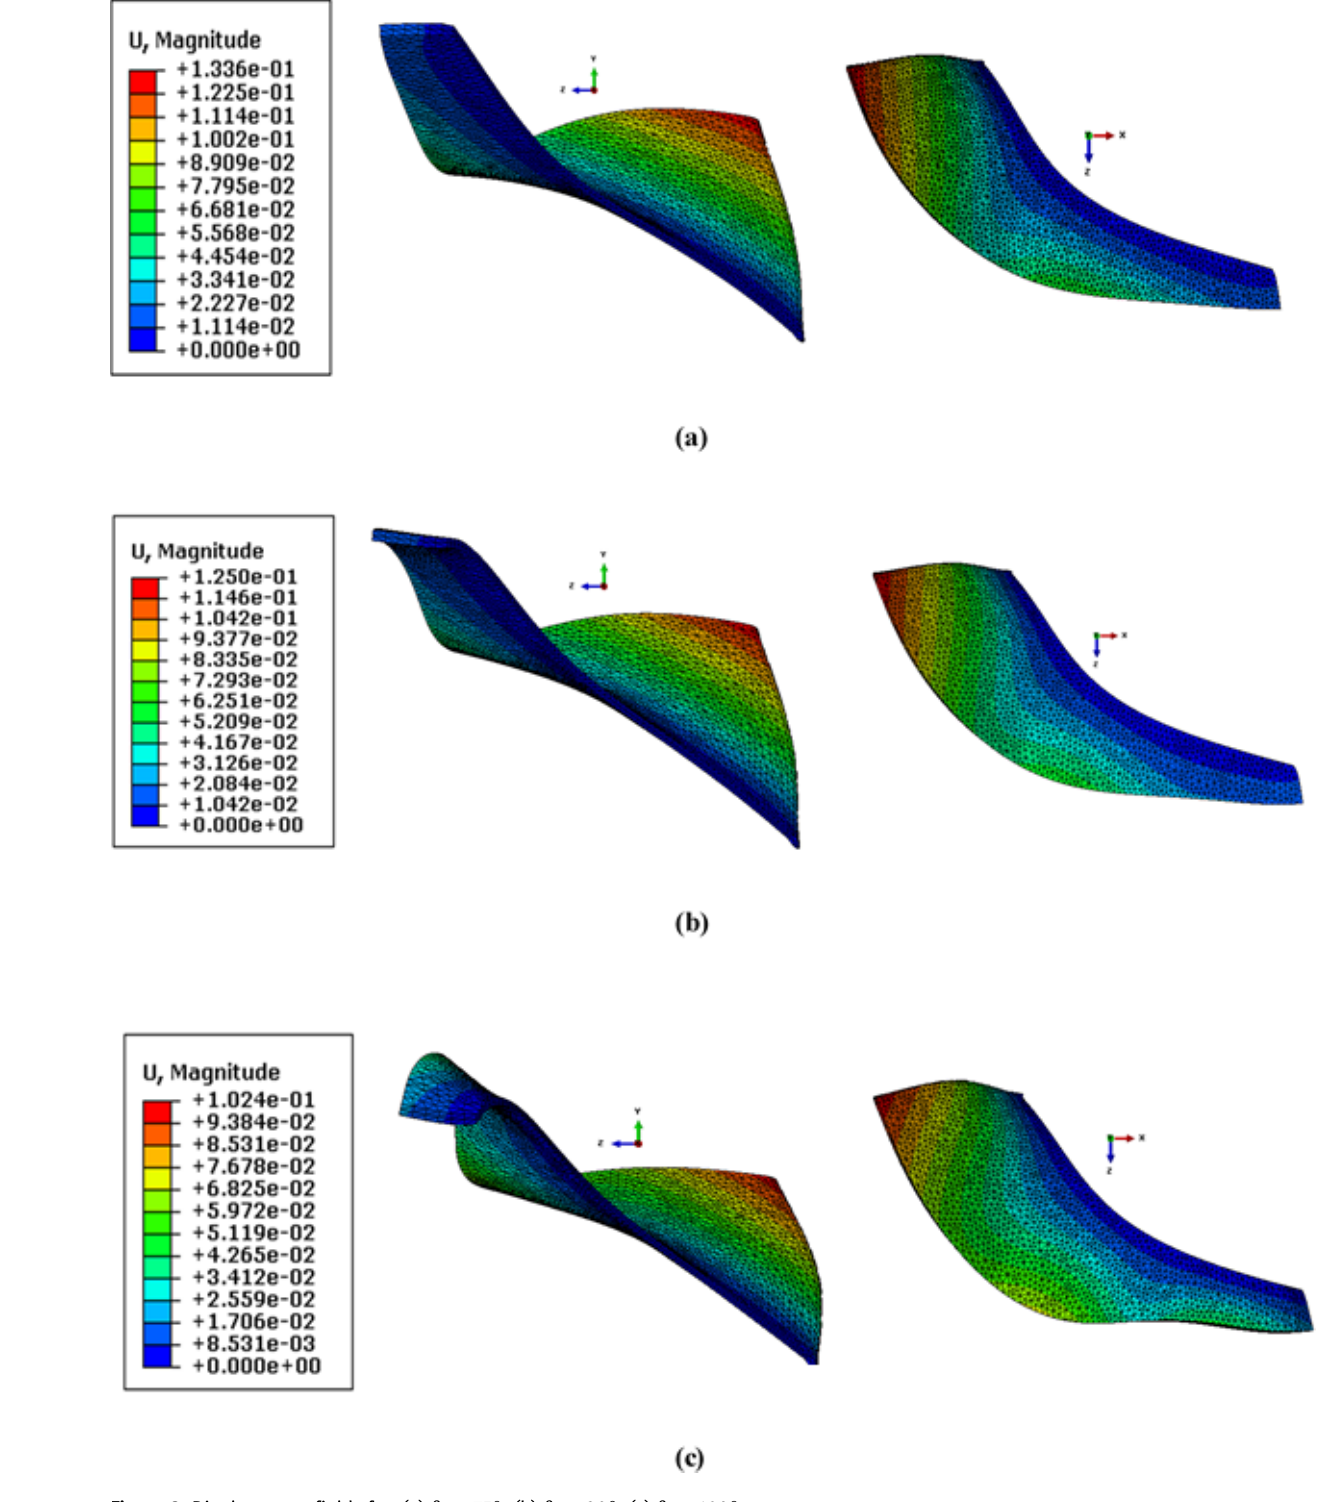
Figure 8: Displacement fields for: (a) β 2 = 75 ∘ ; (b) β 2 = 90 ∘ ; (c) β 2 = 120